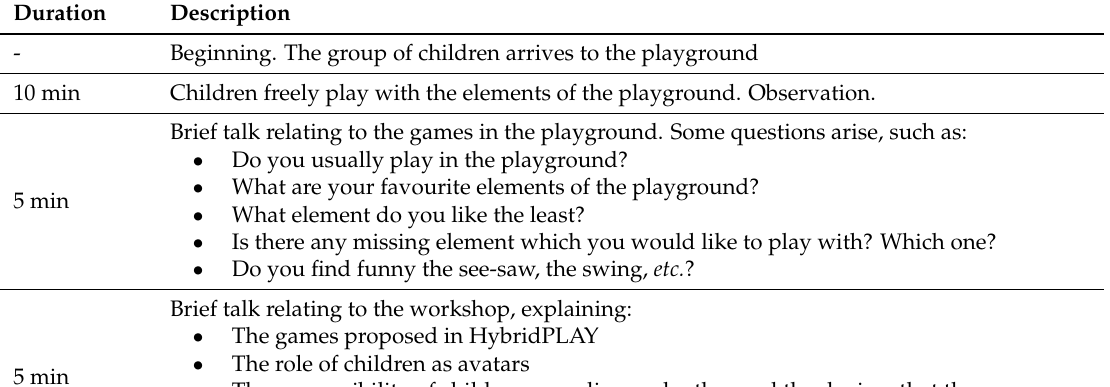
Table 2. Schedule for the